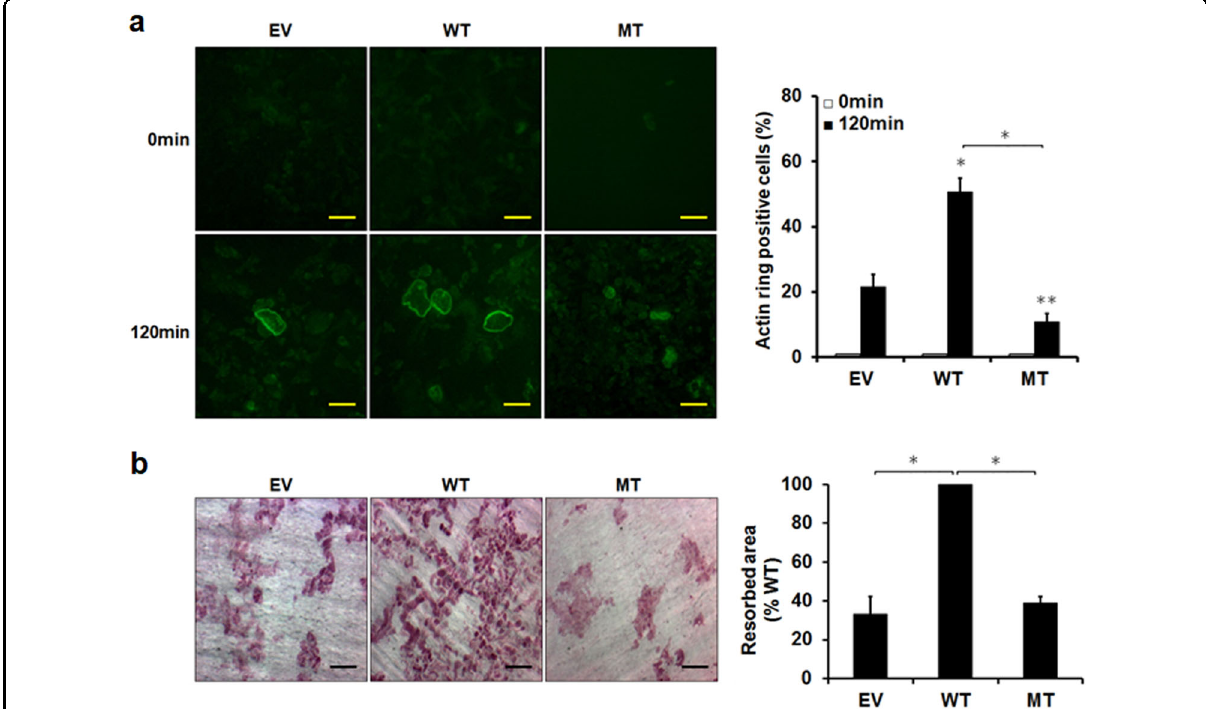
Fig. 5 RACK1 regulates osteoclast cytoskeleton organization and bone resorption through its interaction with c-Src. BMMs transduced with pMX-puro empty vector (EV), pMX-puro-WT-RACK1 (WT), or pMX-puro-MT-RACK1 (MT) were cultured for 3 days with 30 ng/mL M-CSF and 100 ng/mL RANKL to generate mature osteoclasts. a Mature osteoclasts were seeded on bone slices and cultured for 2 days. Actin rings were disrupted by washing the cells with phosphate-buffered saline and then treating them with 100 ng/mL RANKL for 120 min. To visualize the actin rings, the bone slices were fi xed and stained with Alexa Fluor 488-phalloidin. Scale bar, 50 μ m. Right: four fi elds were randomly selected, and the number of intact actin rings was counted (~50 – 100) by two independent assessors. Three bone slices were measured under each experimental condition. The percentage of osteoclasts with actin rings is indicated as actin ring positive cells (%). b Mature osteoclasts were seeded on bone slices and cultured for 3 days. The cells were then removed, and the bone slices were stained. Scale bar, 50 μ m. Right: images of the stained sections were used to calculate the area of resorption pits. Data are presented as the mean ± SD of three independent experiments. * P < 0.01, ** P <